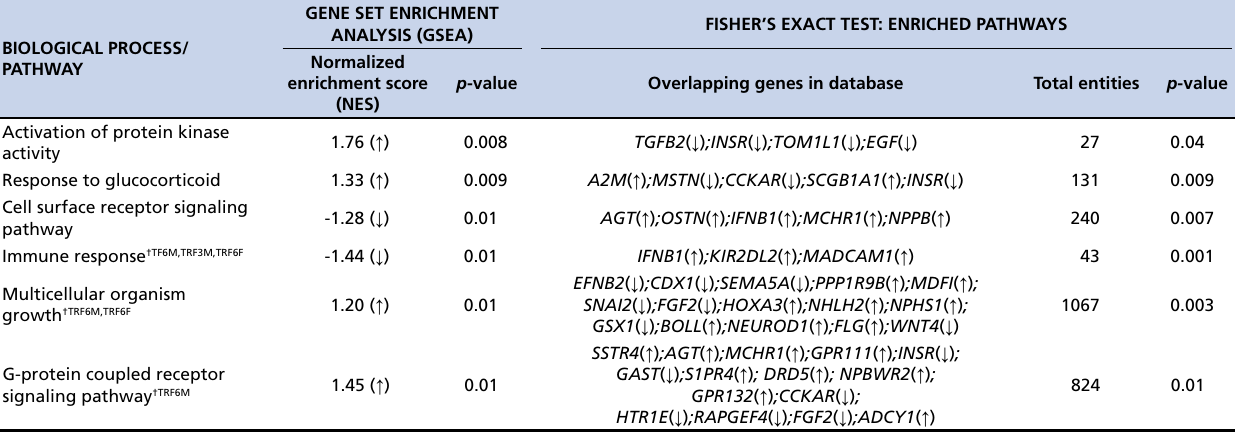
Supplementary Table 7 - List of biological processes significantly modulated in female subjects after 3 months of TRF